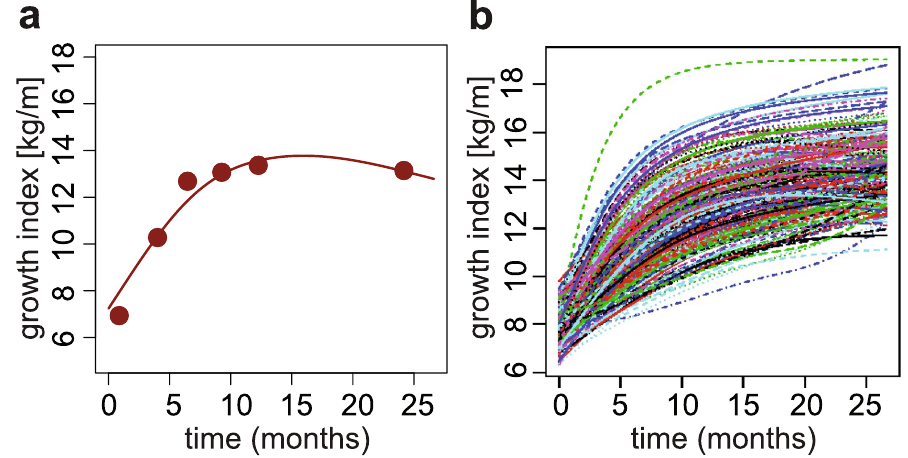
Figure 1. Growth curves construction. ( a ) Example growth curve. Points: observed weight-for-length ratios (i.e. growth indexes); line: estimated growth curve. ( b ) Final aligned growth curves for all children